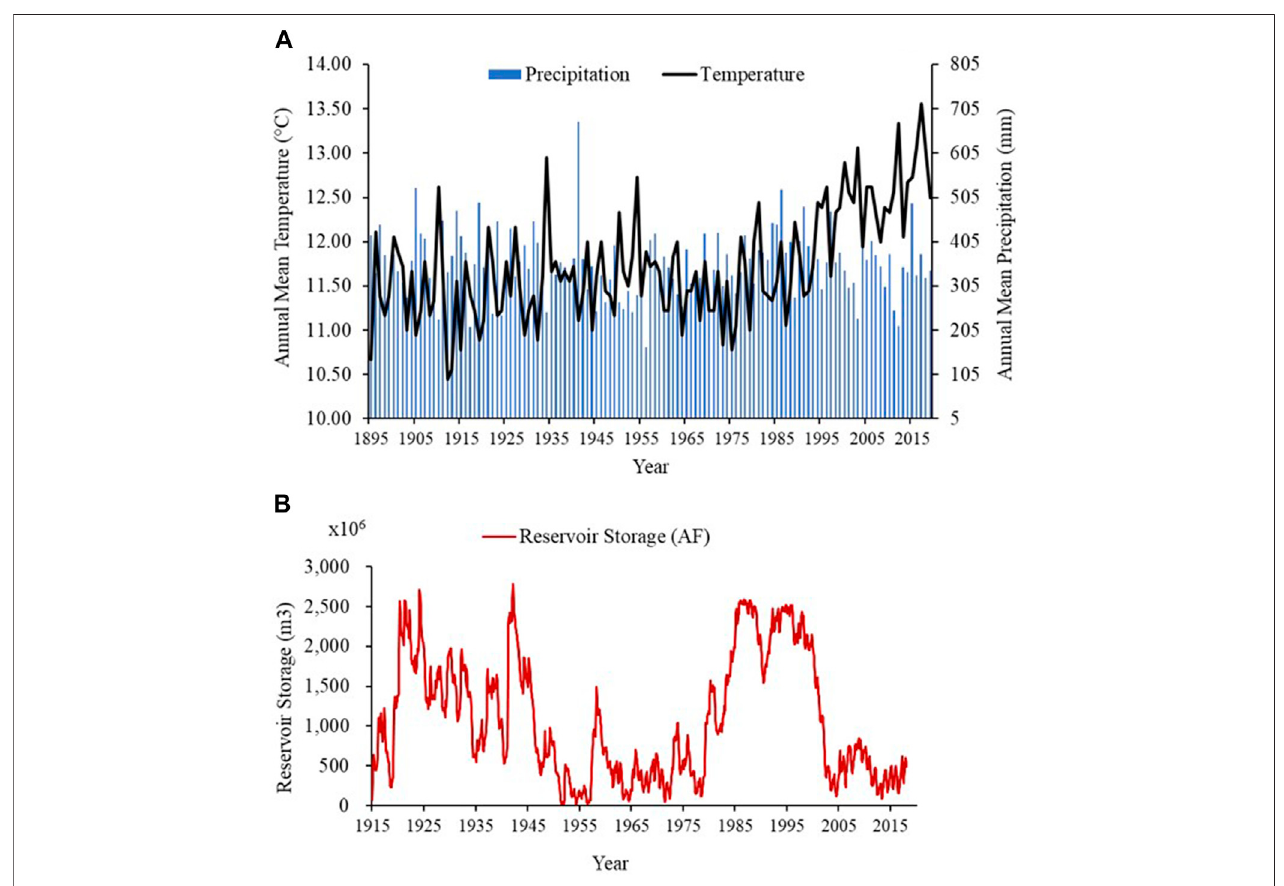
FIGURE 7 | (A) Annual mean precipitation and temperature of the United States and New Mexico from 1895 to 2019 (Source: www.ncdc.noaa.gov/temp-and- precip/) and (B) Elephant Butte Reservoir storage levels (m 3 ) in New Mexico from 1915 to 2020 (Source: USBR, 2021).